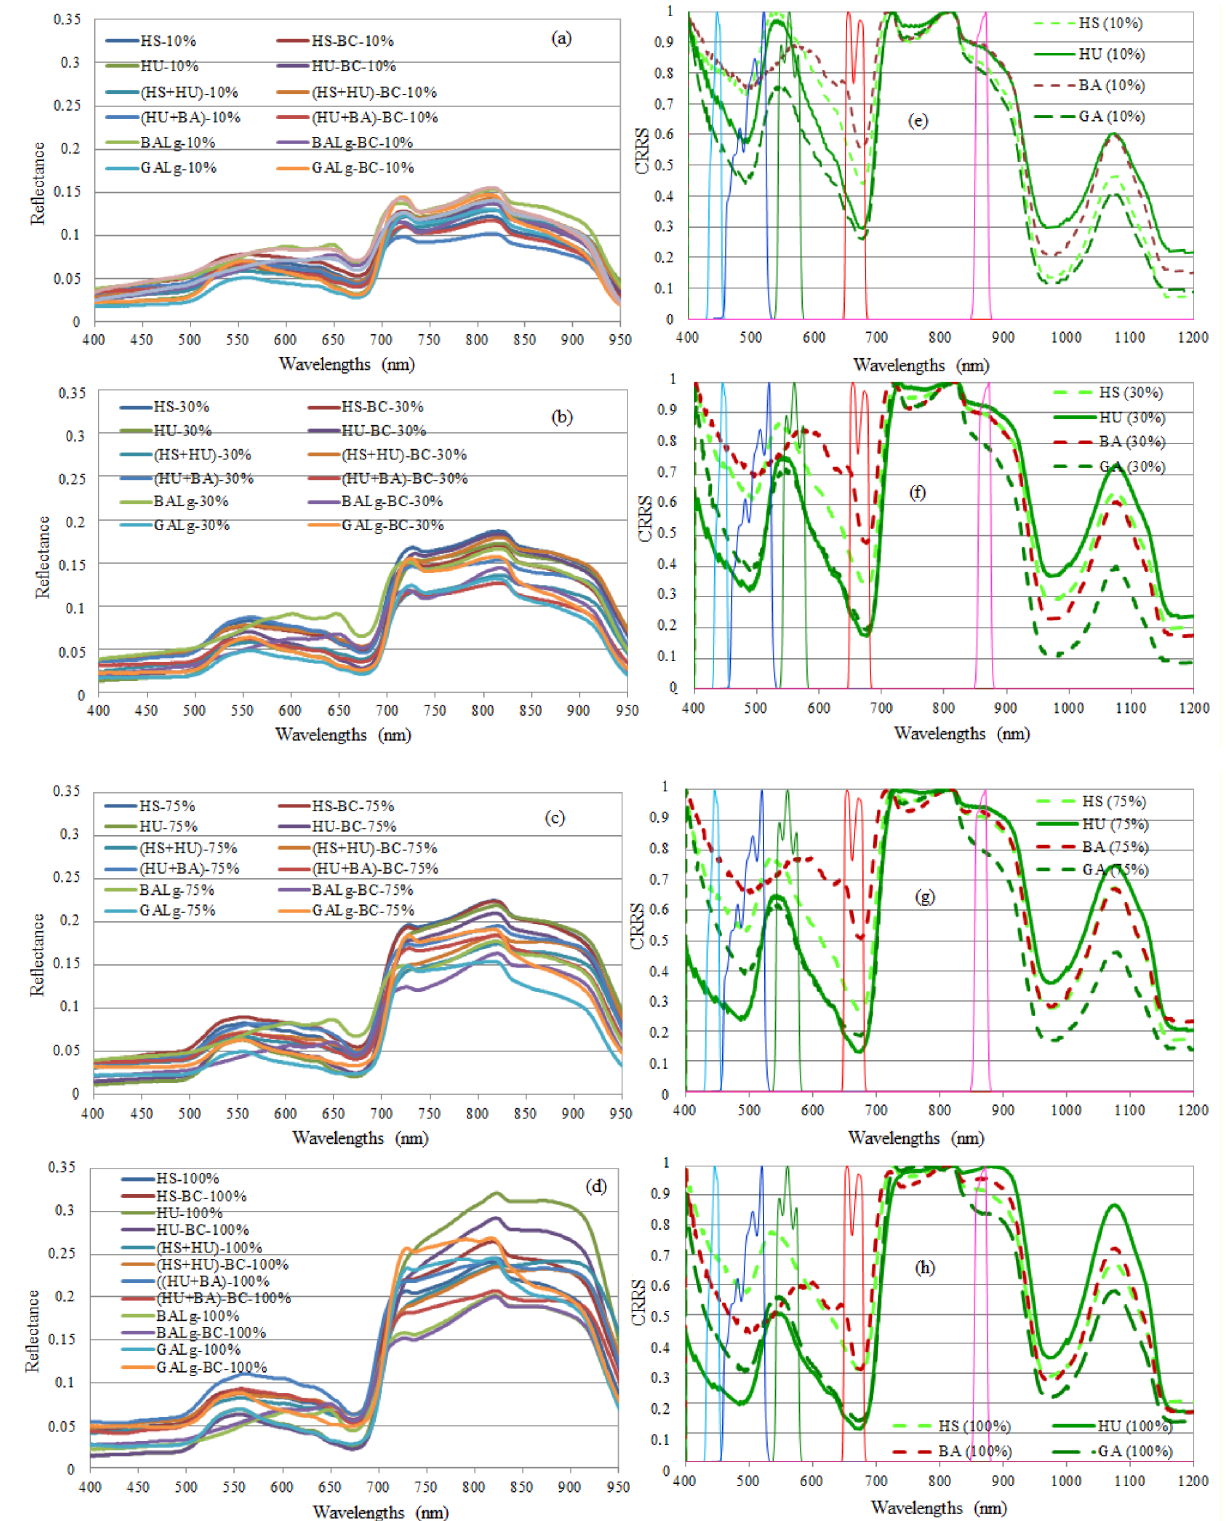
Figure 7. Spectral signatures of seagrass and algae samples at different coverage rates ( a : 10%, b : 30%, c : 75%, and d : 100%) and their CRRS transformations with the filters of Sentinel-MSI VNIR bands presented in Fig.